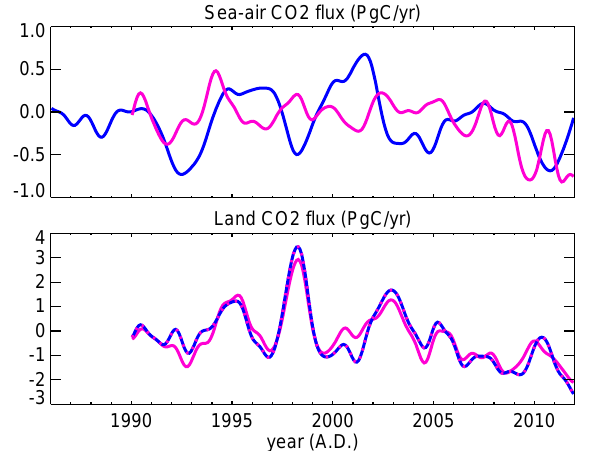
Fig. 7. Top: Interannual anomalies of the sea–air flux of atmo- spheric potential oxygen (APO) in the tropical Pacific, inferred from SOCAT (run SFC , blue) or independently estimated from atmo- spheric O 2 / N 2 ratios and CO 2 mixing ratios (atmospheric APO inversion, R¨odenbeck et al., 2008, 5 sites, updated, orange). Tem- poral filter and sign convention as in Fig. 3. The background shad- Fig. 9. Top: Interannual anomalies of the total ocean CO 2 flux es- ing indicates El Ni˜no (MEI index). Middle: Over selected years Figure 9. Top: interannual anomalies of the total ocean CO 2 flux es- timated by run SFC (blue) and an atmospheric CO 2 inversion (ma- for illustration, sea–air fluxes of CO 2 and O 2 composing the APO timated by run SFC (blue) and an atmospheric CO 2 inversion (ma- genta). Temporal filter and sign convention as in Fig. 3. Bottom: To- flux (Eq. (5)). Bottom: Ocean-internal sources and sinks of DIC genta); temporal filter and sign conventions as in Fig. 3. Bottom: to- tal land CO 2 flux estimated by an atmospheric CO 2 inversion (ma- and O 2 . Vertical axes of all panels span the same range on a molar tal land CO 2 flux estimated by an atmospheric CO 2 inversion (ma- genta – standard Jena inversion (s90 v3.5) with constant priors and basis. genta – standard Jena inversion (s90_v3.5) with constant priors and ocean flux IAV being adjusted from the atmospheric data, dashed ocean flux IAV being adjusted from the atmospheric data; dashed magenta/blue – atmospheric inversion using run SFC as fixed ocean magenta/blue – atmospheric inversion using run SFC as fixed ocean prior). Note threefold vertical range in the land flux panel relative prior). Note threefold vertical range in the land flux panel relative to ocean panel. to ocean